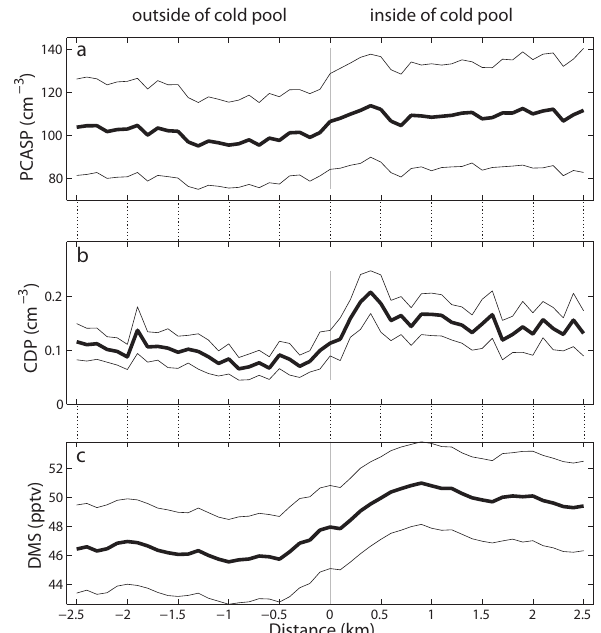
Fig. 15. Composites of (a) PCASP-measured aerosol concentra- tion (0 . 1µm < D < 3µm), (b) CDP-measured aerosol concentra- tion ( D > 1µm), and (c) dimethyl sulfide (DMS) concentration. All variables are composited without taking the anomalies in relation to the cold-pool edge. Bold and thin lines are mean and 95% confi- dence intervals of the